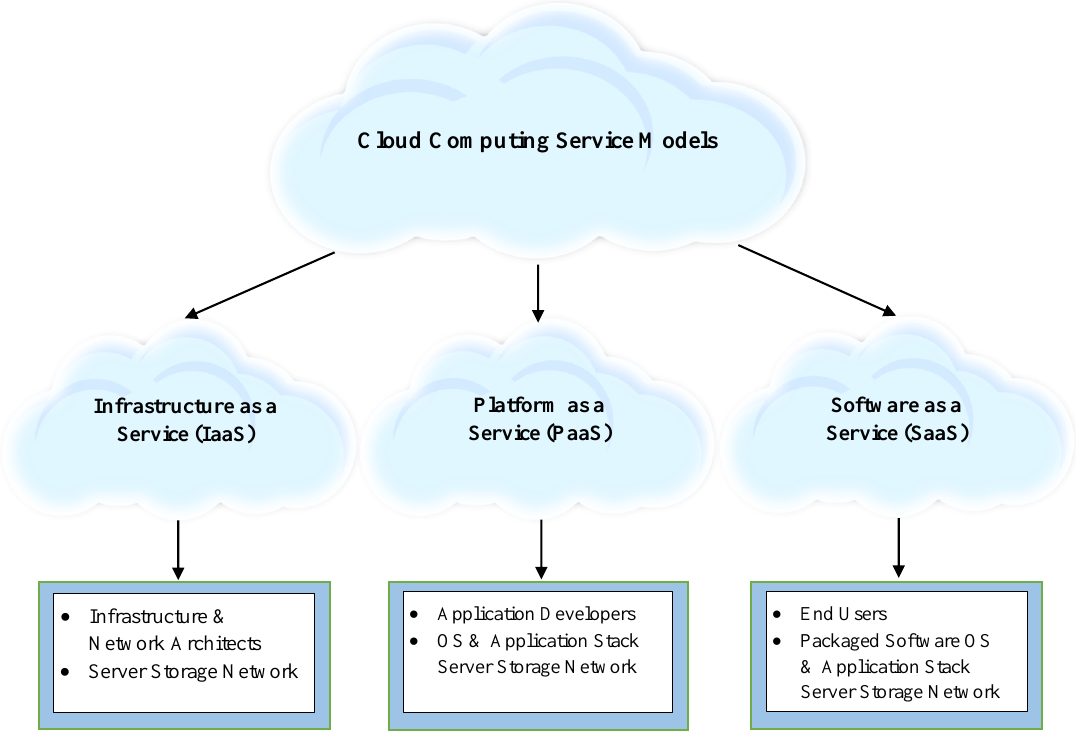
Figure 1. Cloud Computing (CC) service